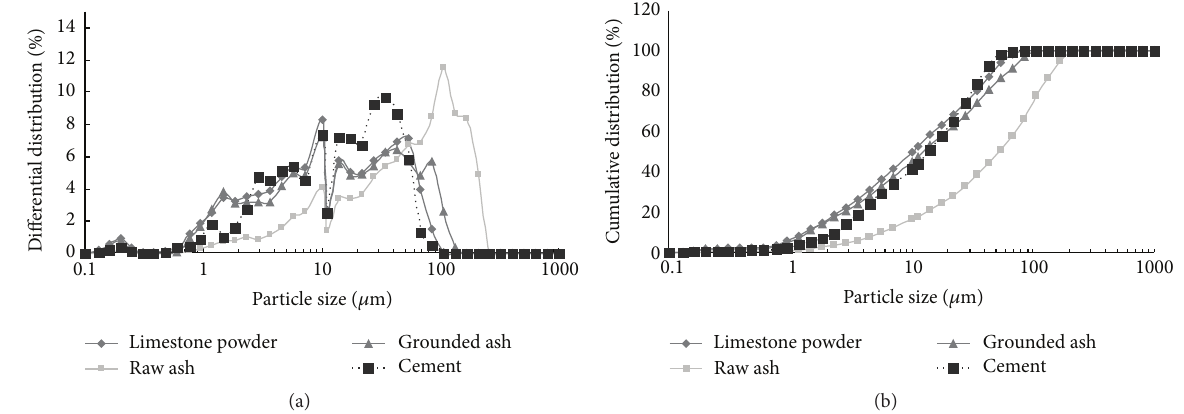
Figure 2: (a) Differential and (b) cumulative particle size distribution of the cementitious materials.